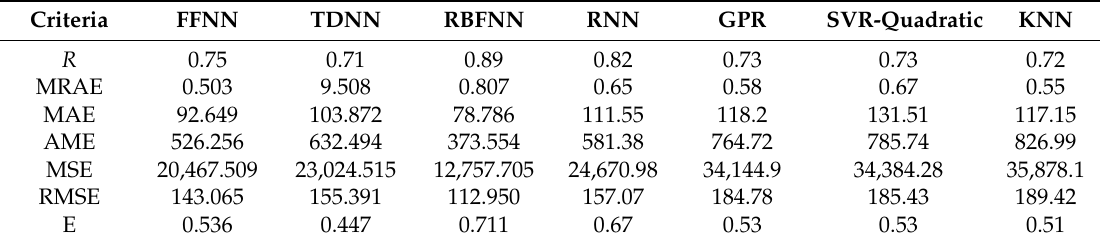
Table 5. Residual criteria for the results of verification data for Dez